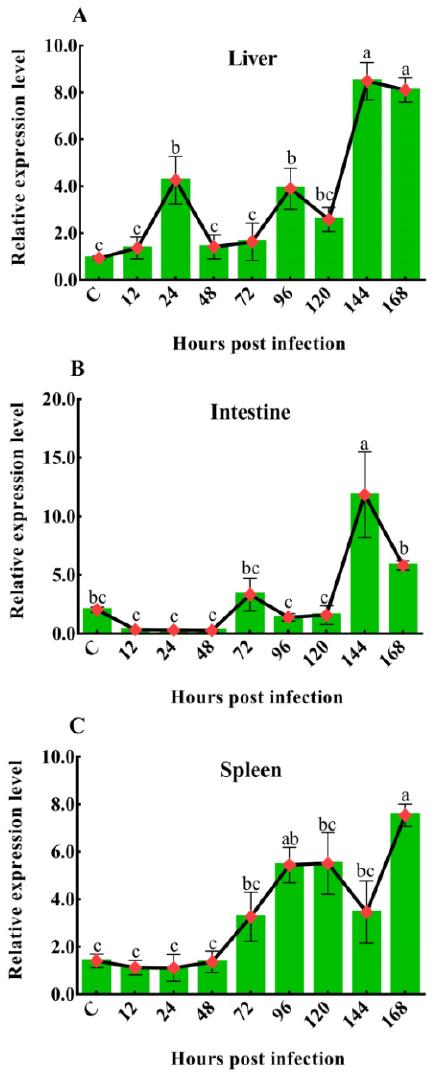
Figure 10. The mRNA expression patterns of Ci Df in the liver ( A ), intestine ( B ), and spleen ( C ) during GCRV infection. Vertical bars represent the mean ± SD. The letters a–c represent significant differences among the expressions in the liver, spleen, and intestine at various time points post-GCRV challenge ( p < 0.05).